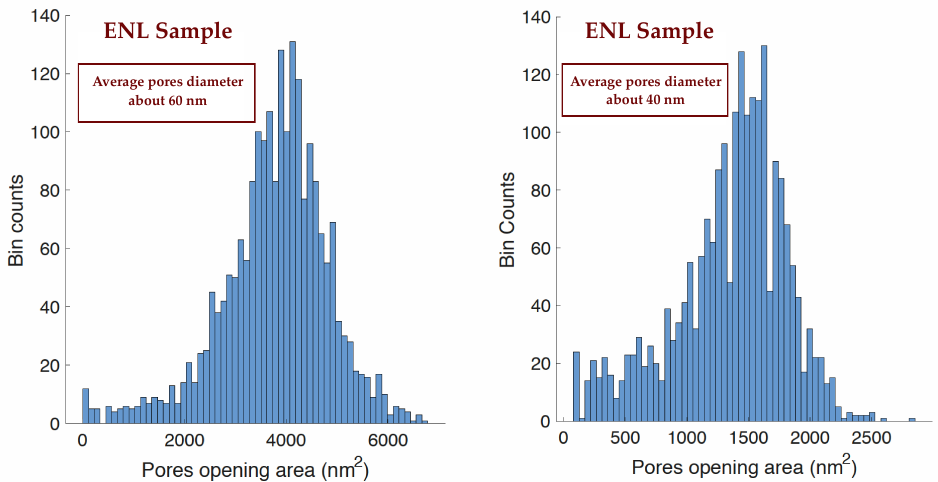
Figure 9. Distribution of the pore opening size for two samples that underwent the ENL process before the formation of the porous layer. The two samples have been fabricated with two different average pore diameters: About 60 nm ( left ) and about 40 nm ( right ).